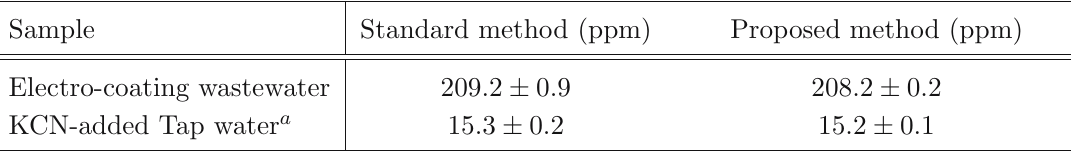
Table 1 Determination of concentration of free cyanide in aqueous samples (n=